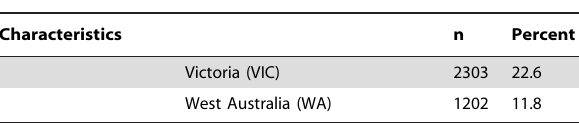
Table 1. Characteristics of all the suicides in Australia (2004–